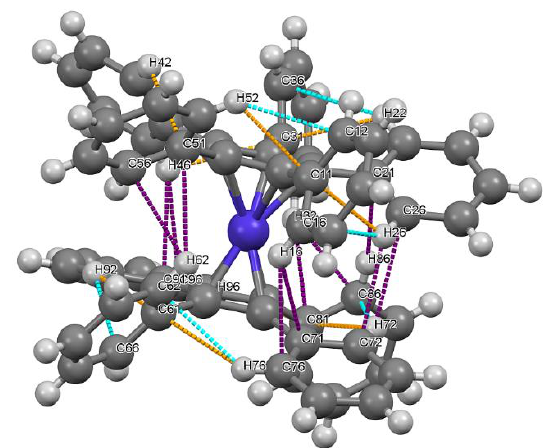
Figure 2. Intramolecular C–H...C interactions in 1 . Color coding: light blue, (C–H) ortho ...C ortho ; orange, (C–H) ortho ...C ipso , both intra ring interactions; violet, (C–H) ortho ...C i,o interactions between phenyls on different rings.